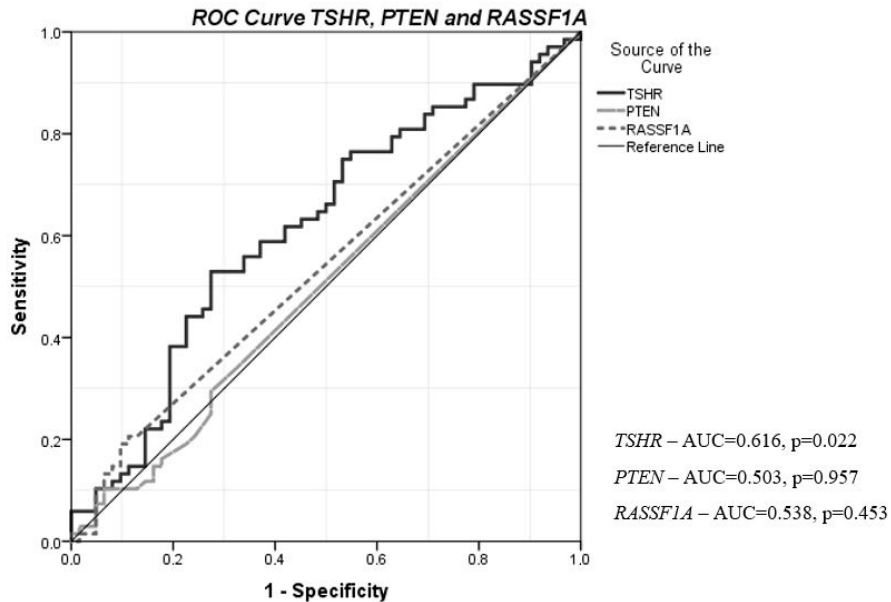
Figure 5. Diagnostic value of plasma TSHR, PTEN , and RASSF1A methylation levels in discrimi- nating PTC from HC. ROC curves were used to distinguish the groups. ROC, receiver operating characteristic; AUC, area under the curve; PTC, papillary thyroid cancer; HC, healthy control.